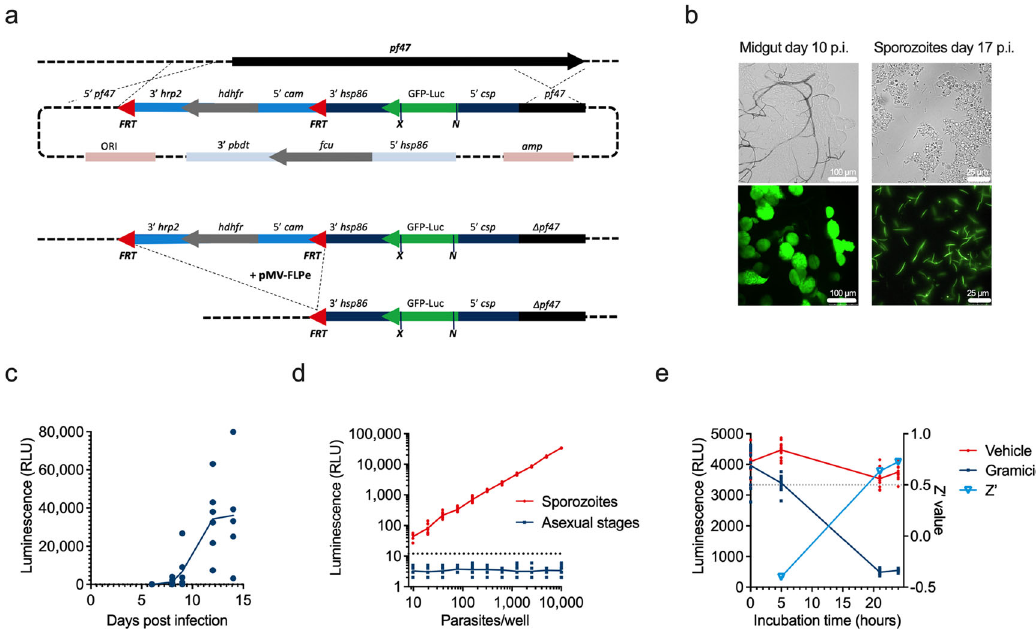
Fig. 1 A reporter parasite strain to assess sporozoite viability. a Schematic of the gene targeting strategy to insert a GFP-Luc reporter gene under